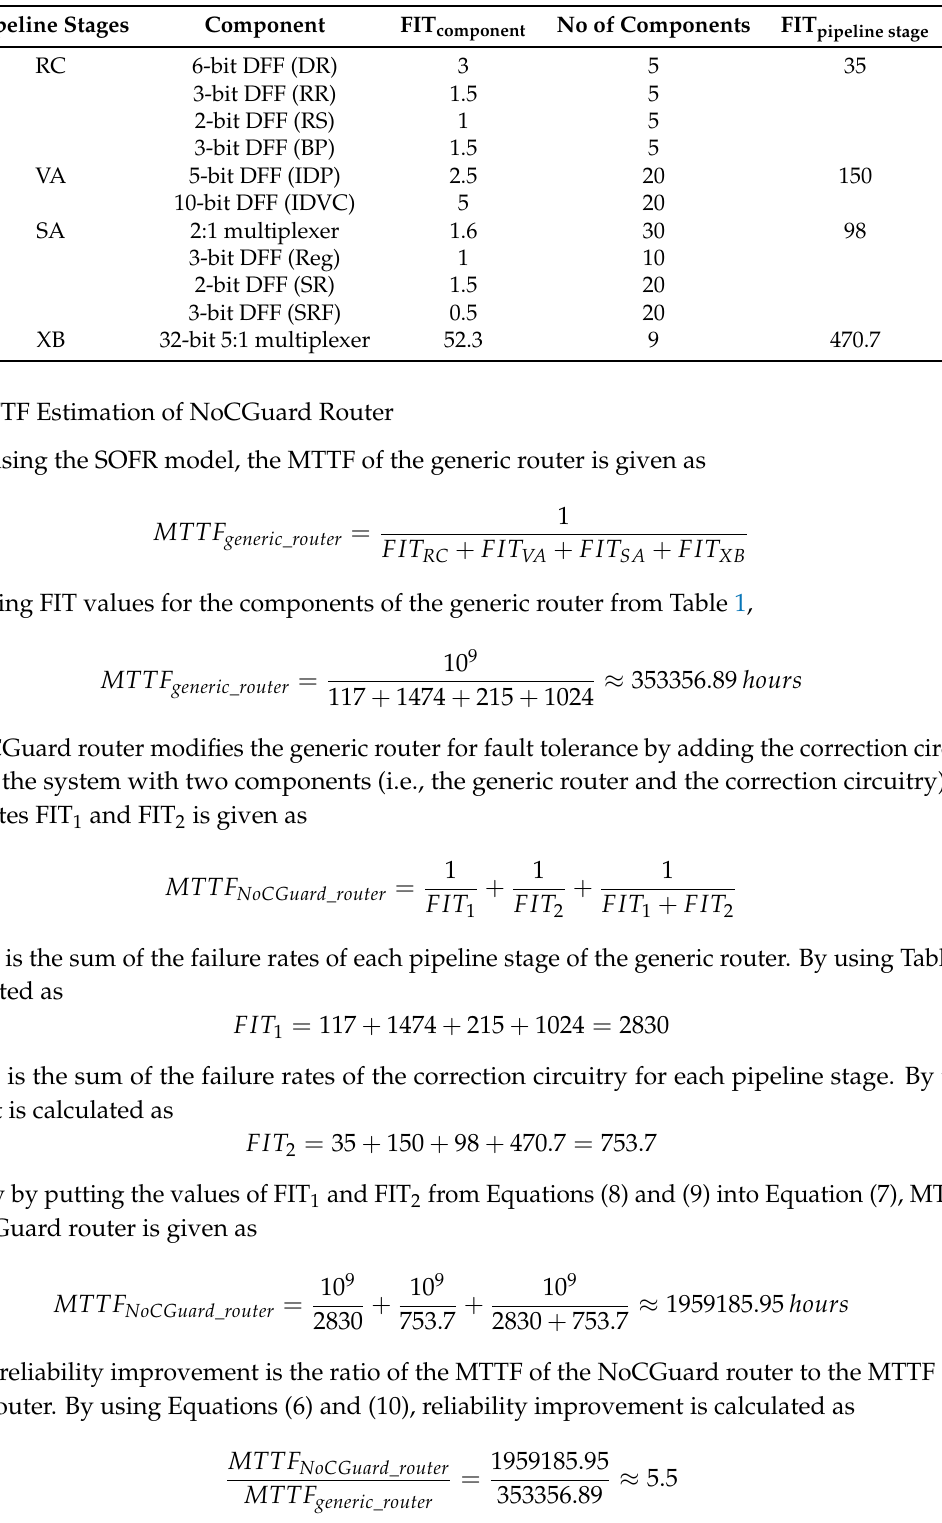
Table 2. FIT Values of Correction